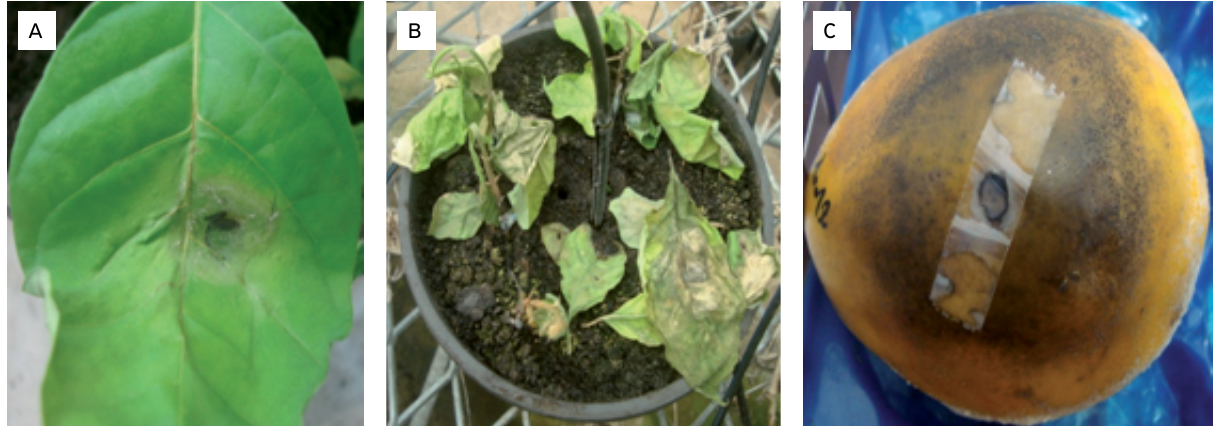
Figure 2. Symptoms of Lasiodiplodia theobromae rot, after pathogen inoculation in leaf (A), plant stem (B) and fruit (C) of sweet passion fruit.